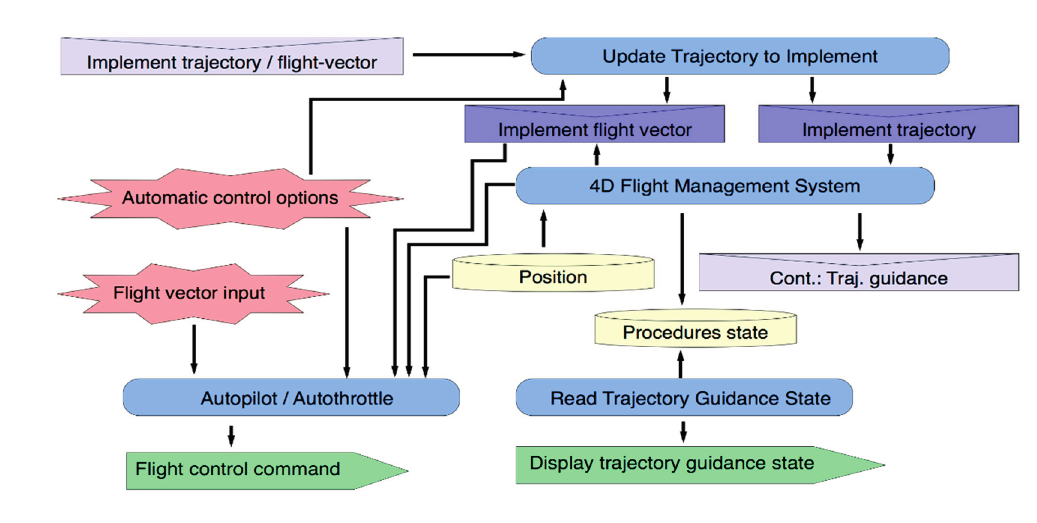
Figure 9. Trajectory Guidance